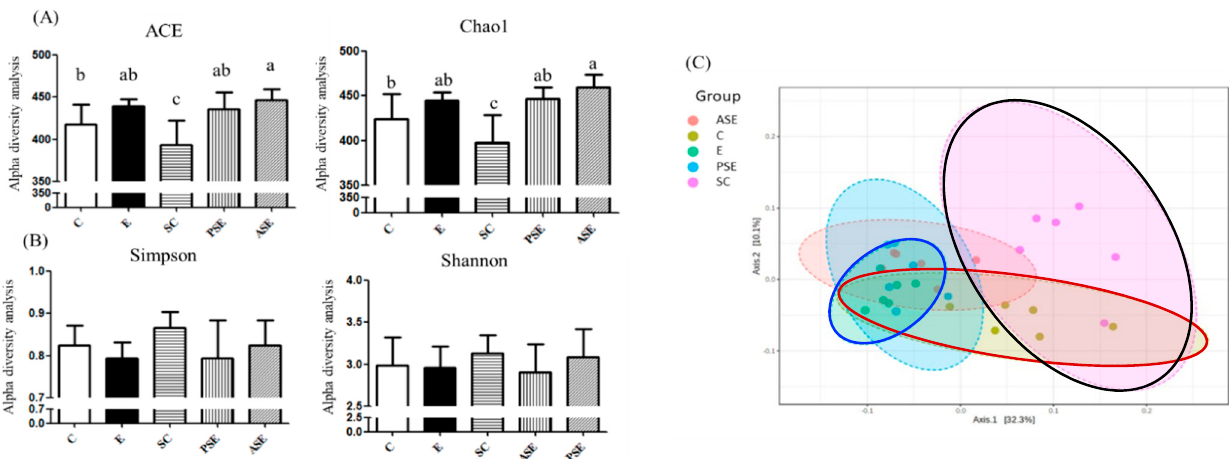
Figure 5. Effects of synbiotics on the α -diversity and principal coordinate analysis (PCoA) of the fecal microbiota in rats with chronic ethanol feeding. ( A ) Richness of the fecal microbiota. ( B ) Diversity of the fecal microbiota. ( C ) Principal coordinate analysis (PCoA) of the fecal microbiota. Bars are the mean ± standard deviation ( n = 6). Different letters indicate a significant difference at p < 0.05 by a one-way ANOVA with Duncan’s post-hoc test. The areas inside the red, blue and black lines represent the microbiota distribution of the C, E and SC groups, respectively.